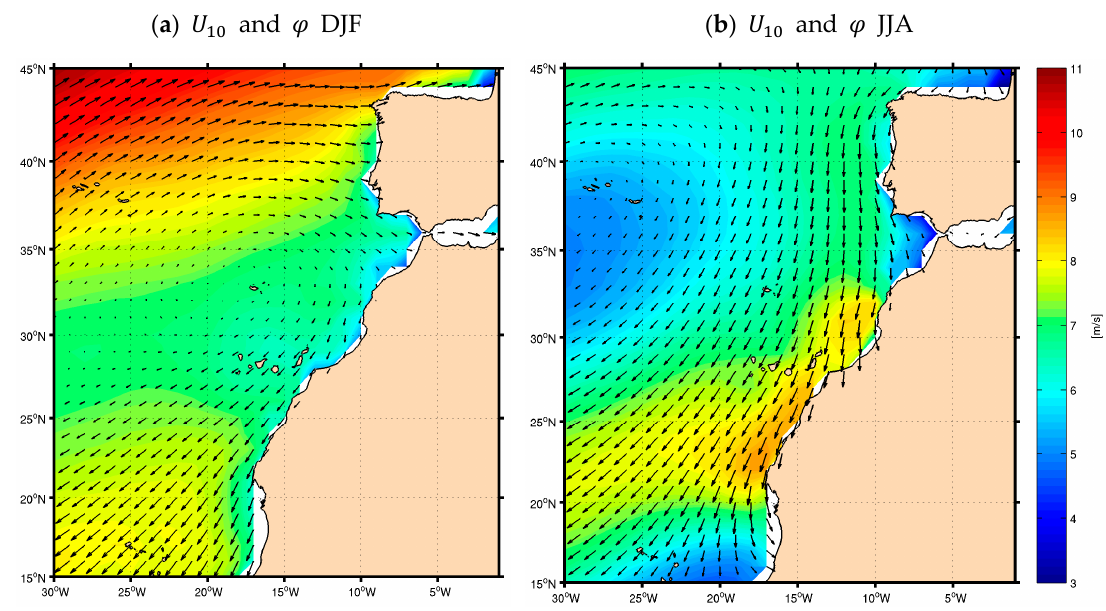
Figure 3. Climatological averages of U 10 (m · s − 1 ) and ϕ ( ◦ ) for ( a ) December to February, Winter (DJF) and ( b ) June to August, Summer (JJA). The arrows are scaled with the corresponding background fields.